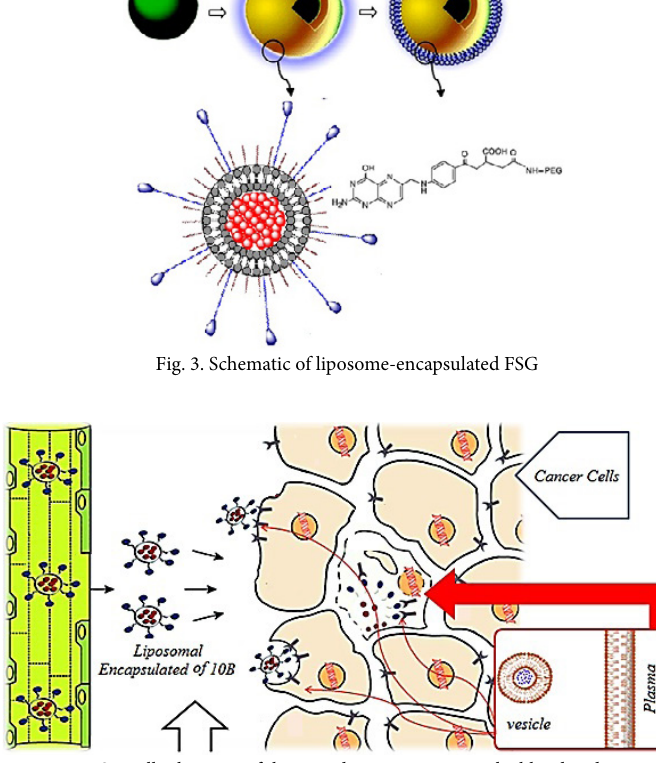
O nanoparticles 3 4